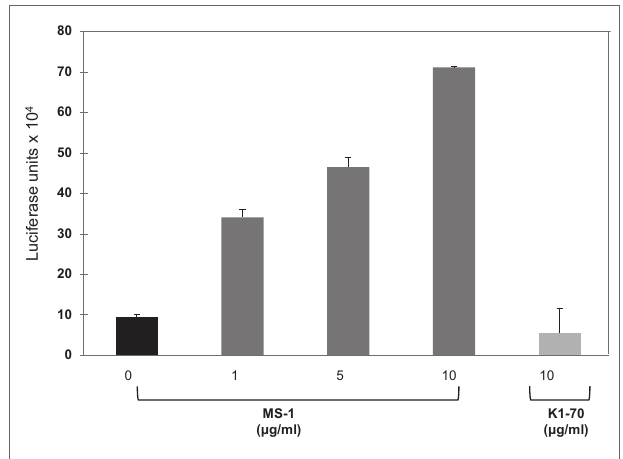
FIGURe 4 | Response of tshR-Glo against stimulating and blocking monoclonal antibody – further proof of the specificity of the assay was obtained by testing a stimulatory monoclonal antibody (Ms-1) and blocking (non-stimulatory) monoclonal tshR antibody (K1-70) in the assay. MS-1 stimulated luciferase activity in a dose-dependent manner, whereas K1-70 was unable to show any response in the assay even at the highest concentration.